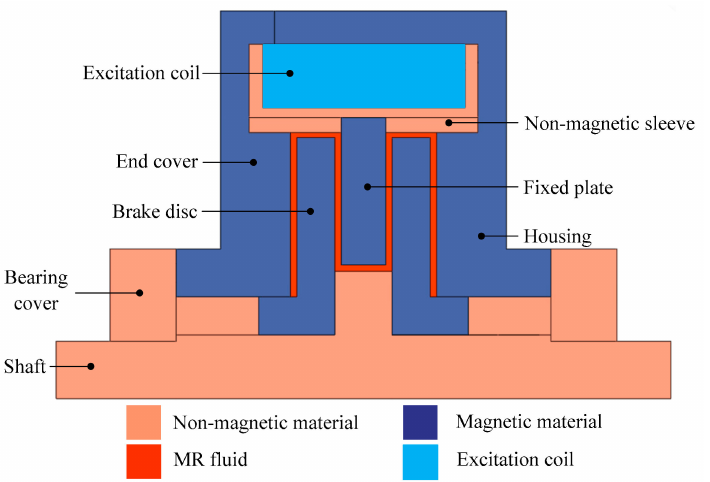
Figure 6. Material distribution for simulation